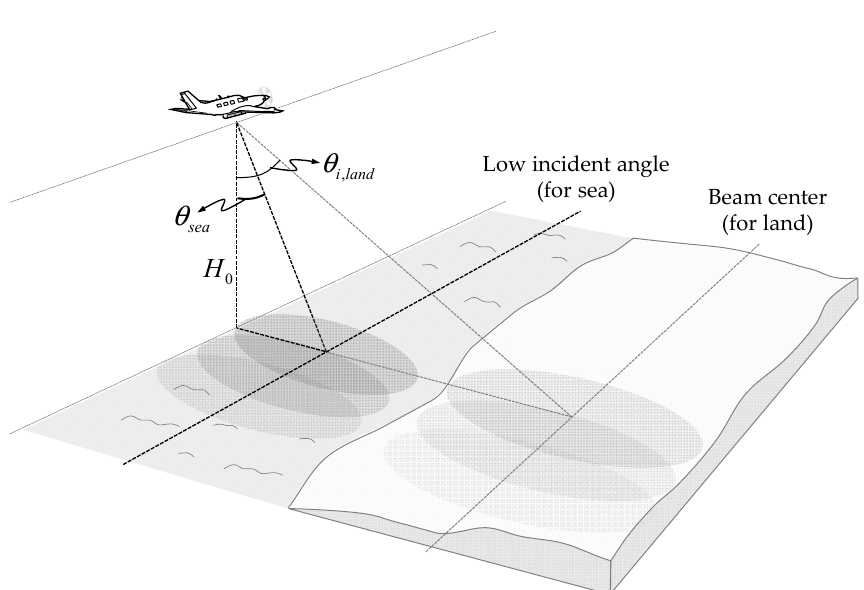
Figure 1. Geometry of the airborne frequency modulated continuous wave–synthetic aperture radar (FMCW SAR) system for a maritime observation mission.